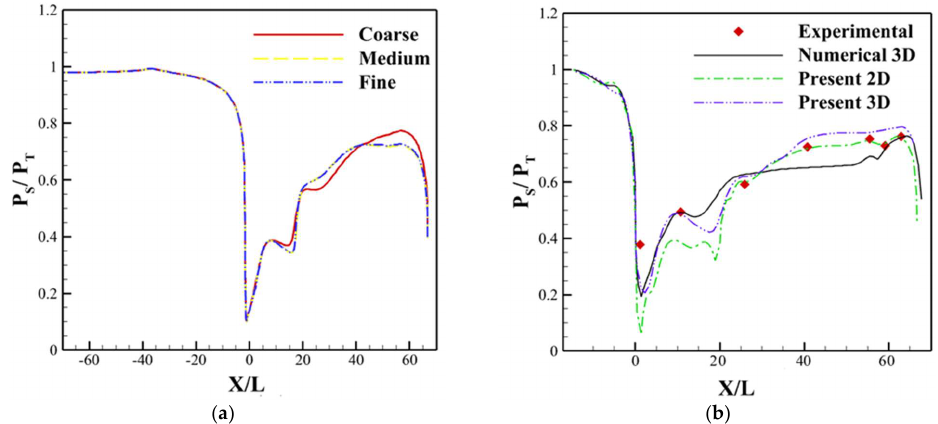
Figure 3. Plot ( a ) static pressure distribution for all three grids. ( b ) comparing static pressure distribution for the experimental and computational calculations at NPR = 3.